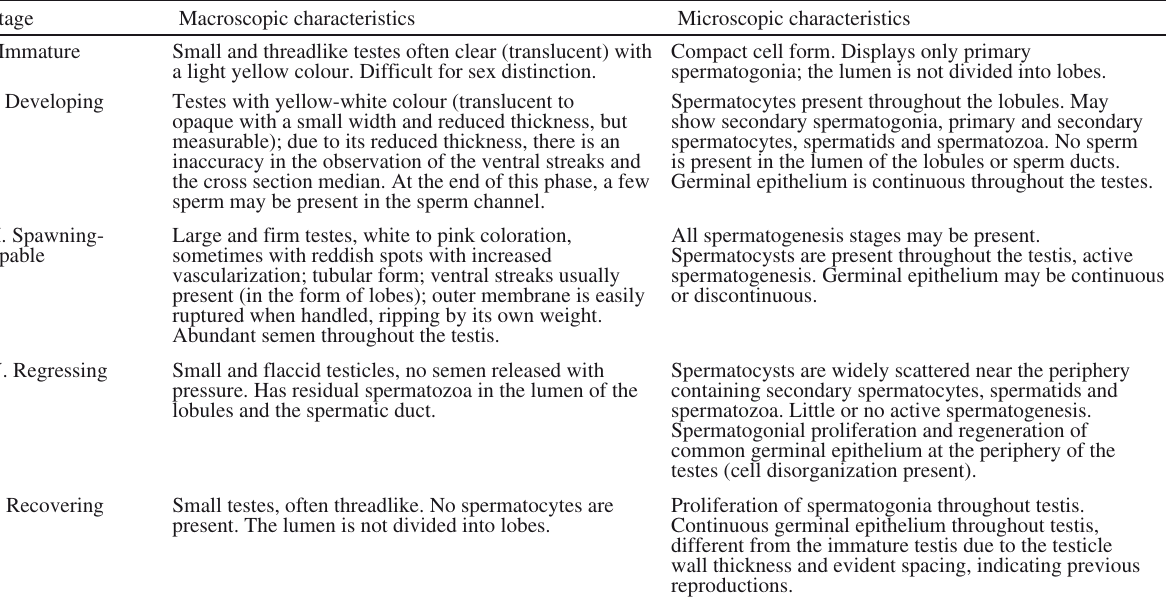
4. – Relative frequency of maturity stages of female dolphin- Fig. 5. – Monthly mean gonadal index (GI) of male dolphinfish, fish, Coryphaena hippurus (n=361), caught in the vicinity of the Coryphaena hippurus (n=175), caught in the vicinity of the Saint Saint Peter and Saint Paul Archipelago between 2007 and 2011 (the Peter and Saint Paul Archipelago between 2007 and 2011 (the bars bars represent the standard deviation). represent the standard Table 4. – Macroscopic and microscopic characterization of the maturity phases of the testes of Coryphaena hippurus in the Saint Peter and Saint Paul Archipelago, adapted from Hunter et al. (1985), Murua et al. (2003) and Brown-Peterson et al. (2011).